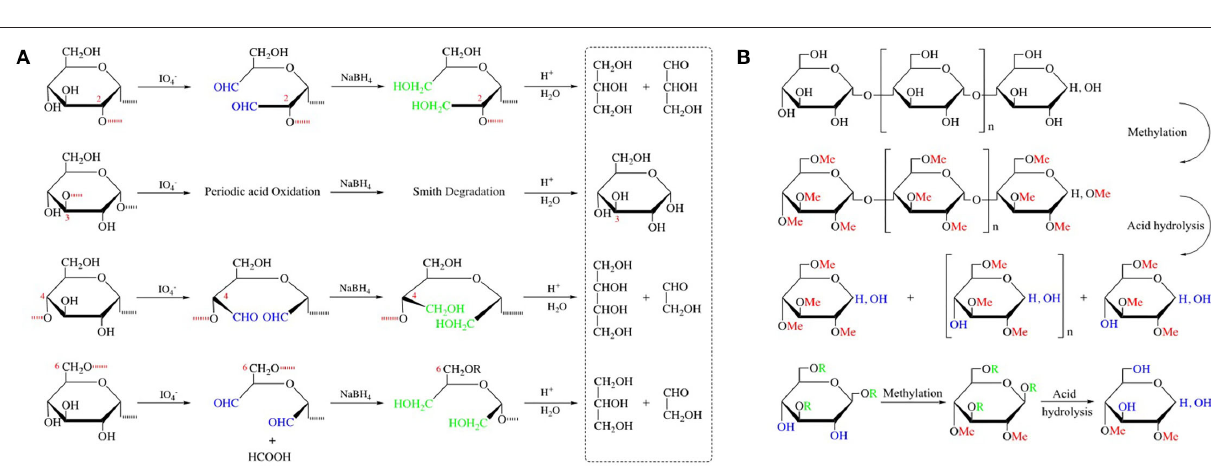
FIGURE 4 | Chemical reactions related to the determination of glycosidic bonds. (A) Different polysaccharides are oxidized by HIO 4 , reduced by NaBH 4 , and then hydrolyzed with dilute acid to obtain different products; (B) Products obtained by methylation and acid hydrolysis of linear glucans and branched